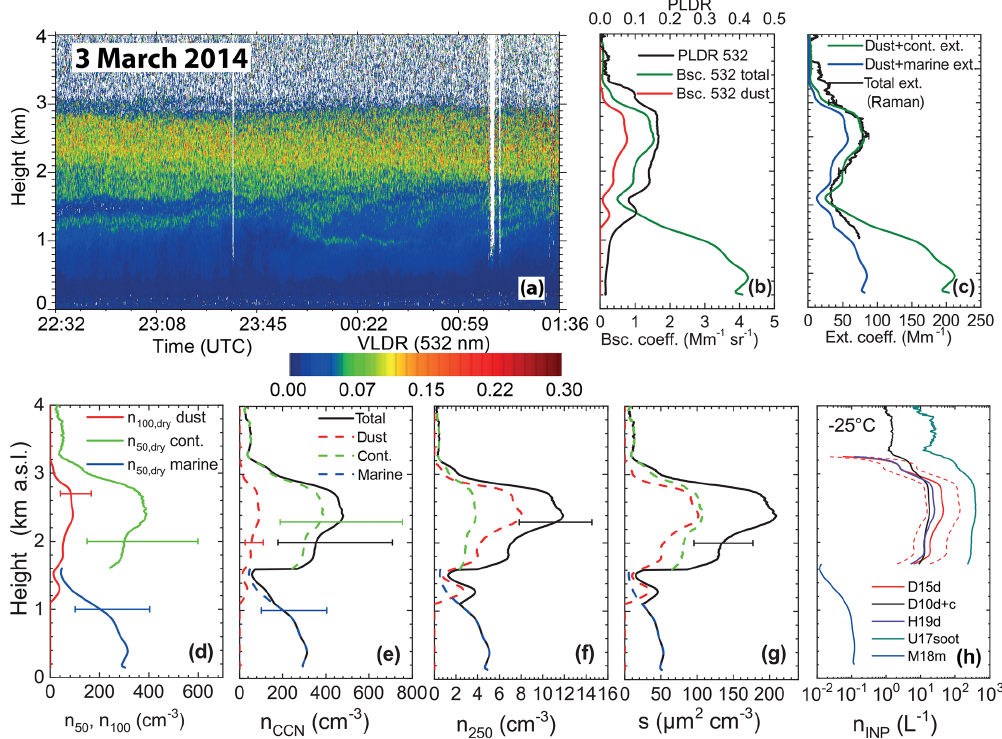
Figure 7. Dust–smoke mixture observed during the SALTRACE winter campaign on 3 March 2014, 22:30–23:20UTC. (a) Time–height display of the 532nm volume linear depolarization ratio (VLDR; only the first 40min are averaged for the profiles in b – h ), (b) particle backscatter coefficient (green line) including its dust contribution (red line) and particle linear depolarization ratio (black line) at 532nm, (c) sum of dust and continental pollution extinction coefficient (green line) using a smoke lidar ratio of 50sr and sum of dust and marine particle extinction coefficient (blue line) using a marine lidar ratio of 20sr compared to the total extinction coefficient (black line) inde- pendently measured with BERTHA (Raman lidar method). Above the height of 1.6km a dust–smoke mixture fits best; below this height, the dust–marine mixture (with a small contribution of smoke or pollution) agrees better with the Raman extinction solution. (d) Number concentration n 100 , d for dust (red), n 50 , c for smoke (green), and n 50 , m for marine particles (blue); (e) CCN number concentrations at water supersaturation of 0.2% for the three components and the total CCN concentration (black line) above 1.6km for dust–smoke and below for dust–marine; (f) n 250 values (colors as before); (g) surface-area concentration (colors as before); and (h) immersion-freezing INP concentra- tions at − 25 ◦ C for D10 cont. + dust, D15 dust, H19 dust, M18 marine, and U17 soot. For the INP concentration an uncertainty of a factor of 3 is indicated as dashed lines for the D15d